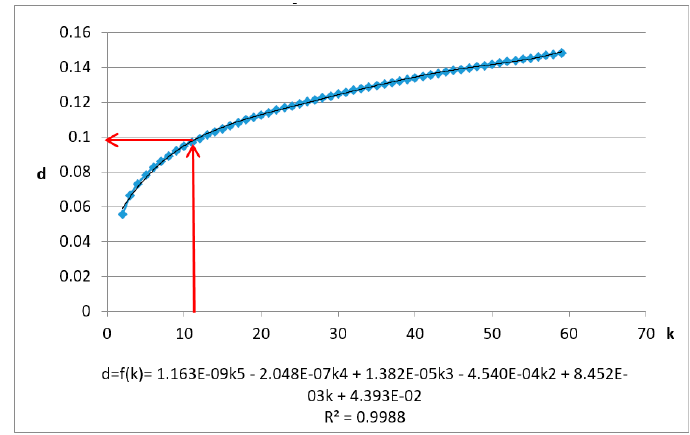
Figure 10. Chart and fitting curve of the mean max distance of k nearest neighbor of airborne laser scanning data using X , Y , Z , R, G, B fields.